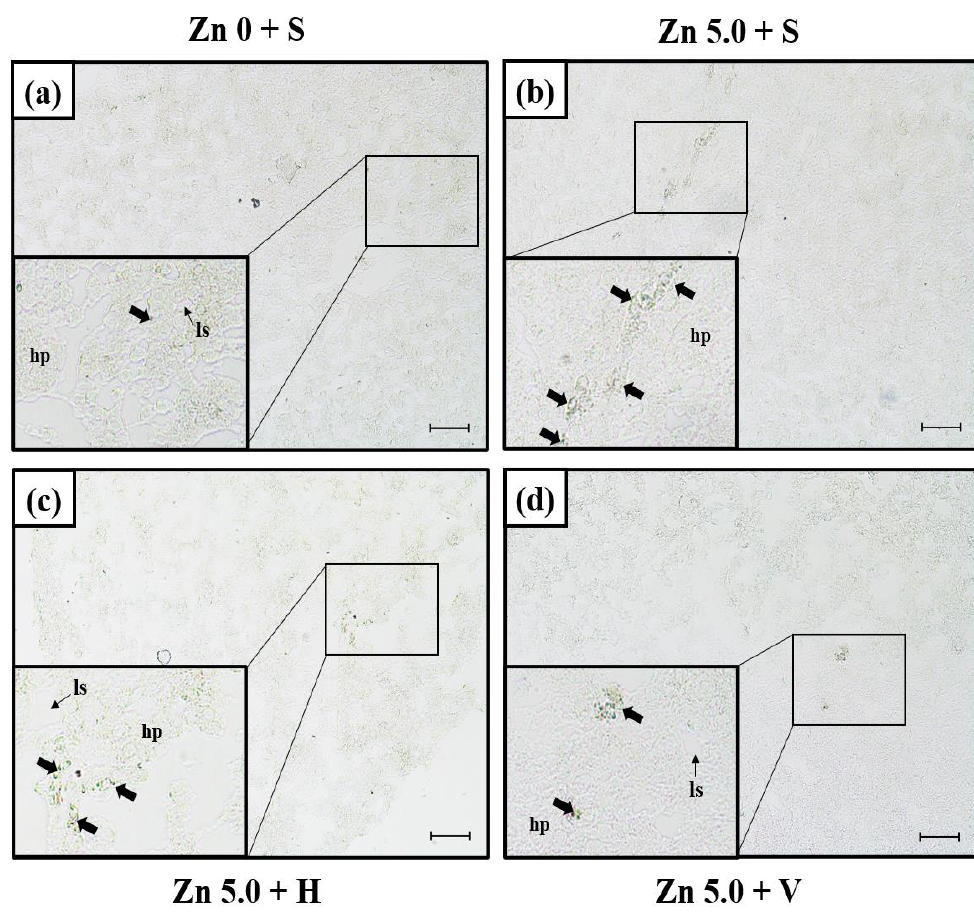
Figure 2. Detection of SOD mRNA expression in liver of goldfish by in situ hybridization: ( a ) Zn 0 + S (control) expression site and magnification of mRNA expression site in ( a ); ( b ) Zn 5.0 + S expression site and magnification of mRNA expression site in ( b ); ( c ) Zn 5.0 + H expression site and magnification of mRNA expression site in ( c ); ( d ) Zn 5.0 + V expression site and magnification of mRNA expression site in ( d ). The dark area (black arrow) indicates the expression of SOD mRNA in liver (s cale bars = 50 μm). Abbreviation: hp; hepatocytes, ls; liver sinusoid.